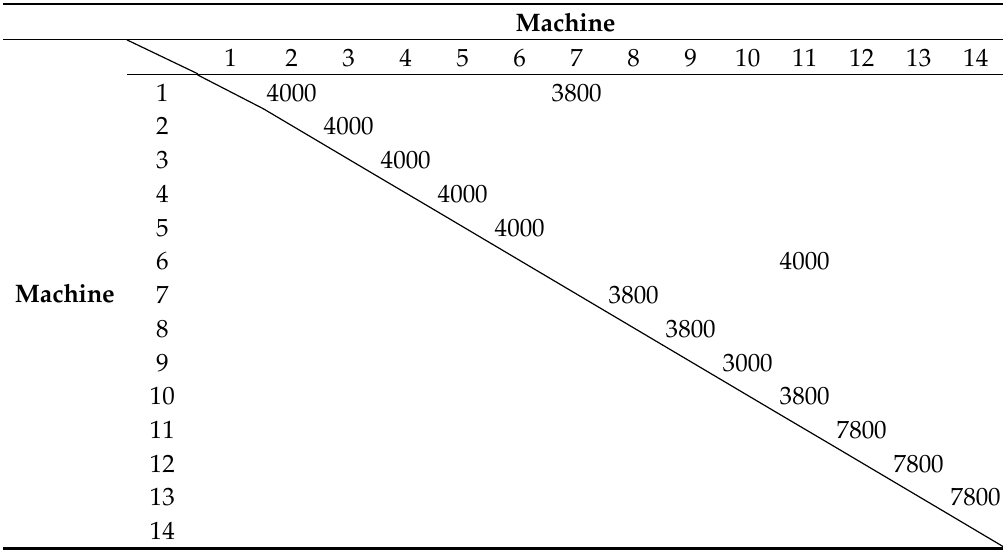
Table 4. Flow matrix f ij .